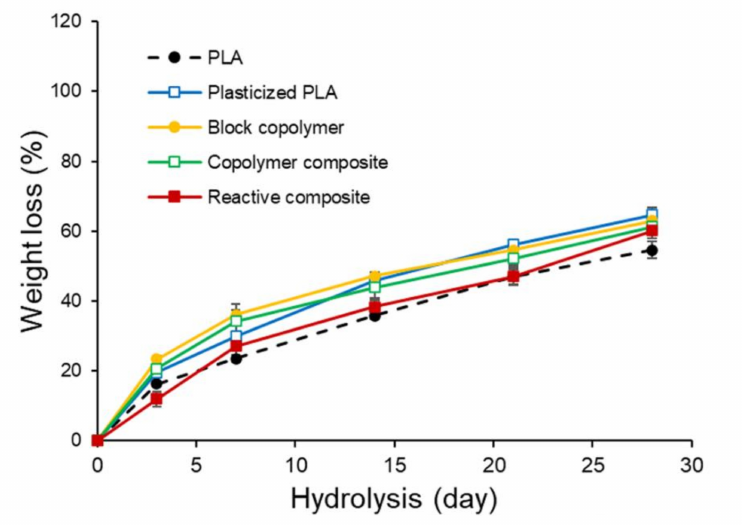
Figure 6. Evolution of weight loss with increasing hydrolysis time for PLA, plasticized PLA, block copolymers and